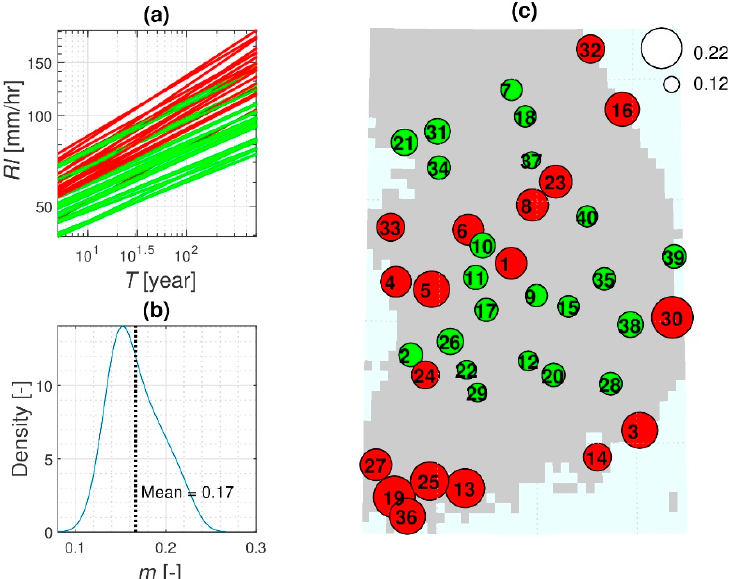
Figure 6. Varying degree of increase of rainfall frequency estimates ( RI ) over return periods ( T ) for 1-h duration for future END period of RCP 8.5. Subplot ( a ) illustrates the rainfall frequency estimates over return periods for 40 locations. Subplot ( b ) is a kernel distribution of the slopes ( m ) for 40 lines in subplot ( a ). The red (green) lines in subplot ( a ) refer to locations with their slopes greater (smaller) than mean value—the dark dash lines in subplot ( b ). Subplot ( c ) illustrates the spatial distribution of the slope, the colored circles correspond to the colored lines in subplot ( a ). The number near white circles is the legend to show the relative magnitude of slopes.